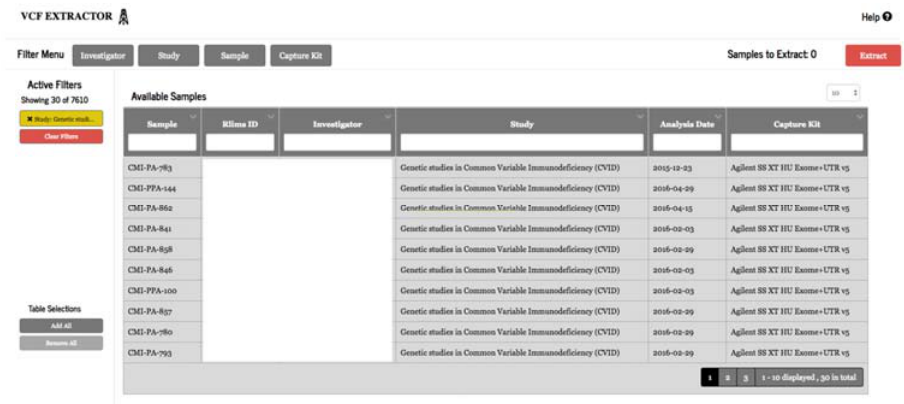
Figure 5. VCF extractor.